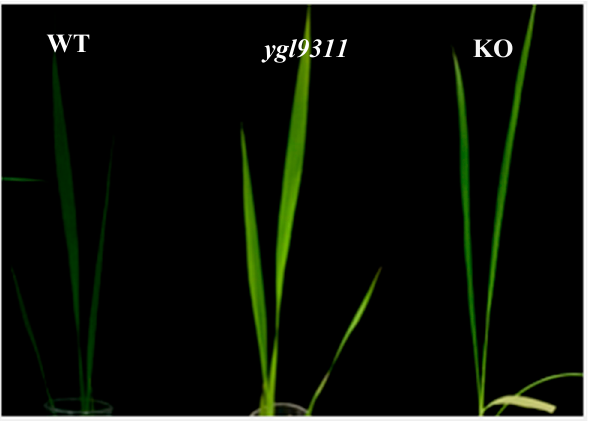
Figure 8. The phenotypes of the transgenic receptor parent indica 9311 (WT), mutant ygl9311 , and knockout transgenic plant (KO) at seedling stage.